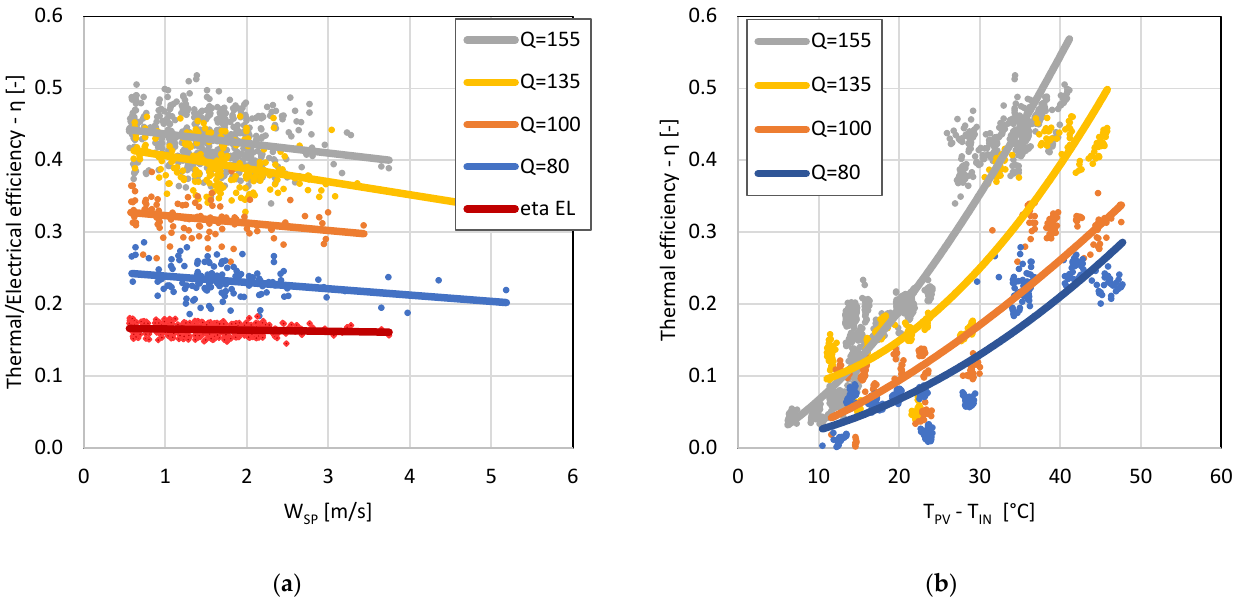
Figure 5. Thermal and electrical efficiency of individual panel grouped at different fluid flow levels (Q in m 3 /h) versus: ( a ) external wind speed and ( b ) maximum temperature gain (T PV –T IN ). Thermal efficiency was also analyzed regarding the average temperature of the fluid during the operation ( T m ) and the environmental temperature ( T a ). In these cases, both variables seemed to have a very slight effect on the thermal performance with no clear trend. Instead, the effect of the fluid temperature is studied with regard to the PV laminate temperature, since it limits the maximum gain of the air through the panel. Trends are